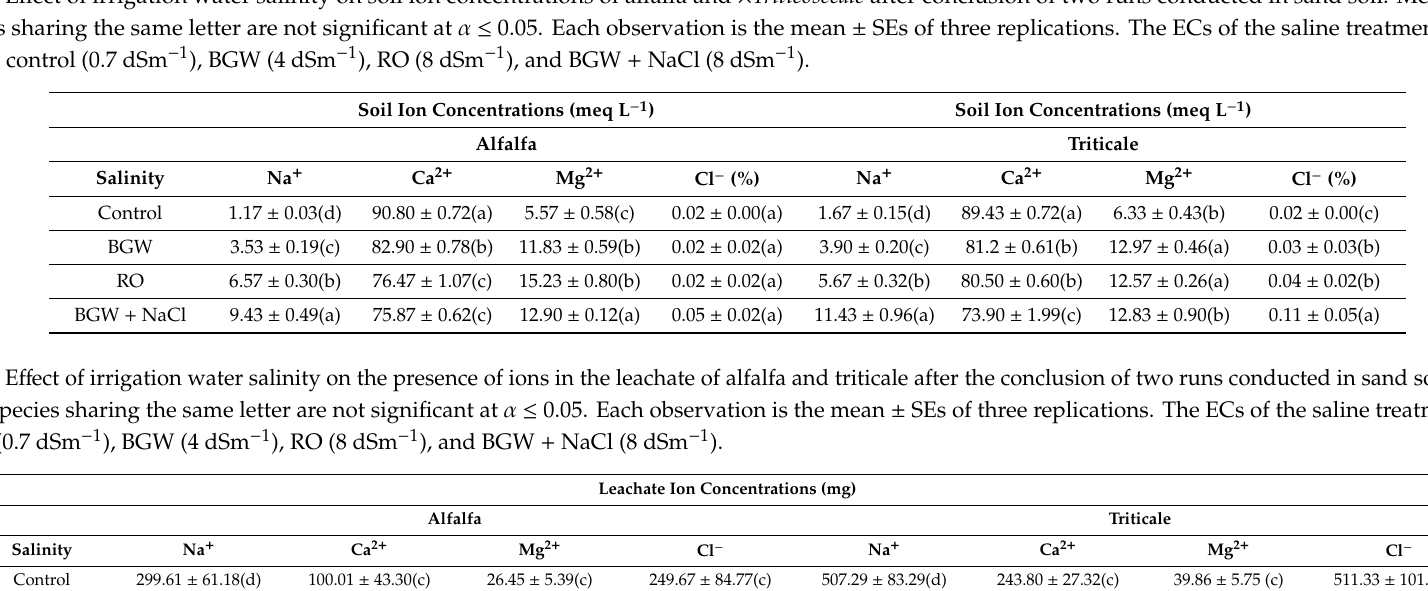
Table 3. E ff ect of irrigation water salinity on soil ion concentrations of alfalfa and × Triticosecale after conclusion of two runs conducted in sand soil. Means within columns sharing the same letter are not significant at α ≤ 0.05. Each observation is the mean ± SEs of three replications. The ECs of the saline treatments were as